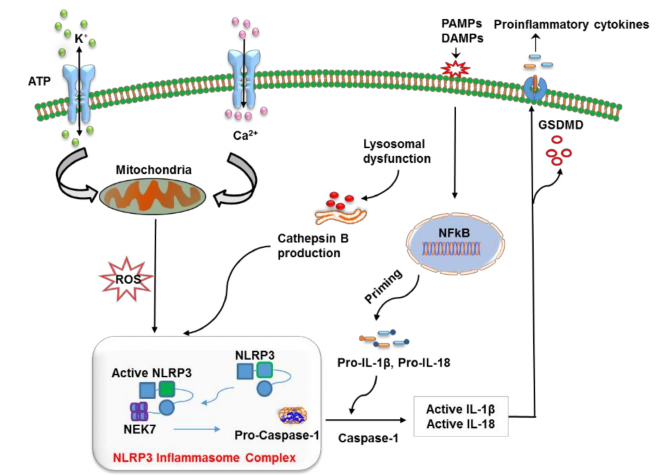
Figure 1. The mechanism of action of the nucleotide-binding oligomerization domain-like receptor (NLR) family pyrin domain containing 3 (NLRP3) inflammasome. The priming step involves the recognition of a pathogen-associated molecular pattern (PAMP) or a damage-associated molecular pattern (DAMP) by a specific pattern recognition receptors (PRR), which activates the NF- κ B pathway to release precursor forms of IL-1 β and IL-18 into the cytoplasm. NLRP3 is turned on by lysosome-mediated cathepsin B, K + efflux, reactive oxygen species (ROS) production via dysfunctional mitochondria, the release of mitochondrial DNA in oxidized form, and alterations in Ca 2 + concentration. The oligomerization and activation of NLRP3 take place after it interacts with the leucine-rich repeat (LRR) domain of NEK7. This event is followed by the cleavage of pro-caspase 1 into caspase 1, which converts pro-IL-1 β and pro-IL-18 into their respective mature forms, which are finally released from the cell via pores generated by gasdermin D (GSDMD) (N-terminal